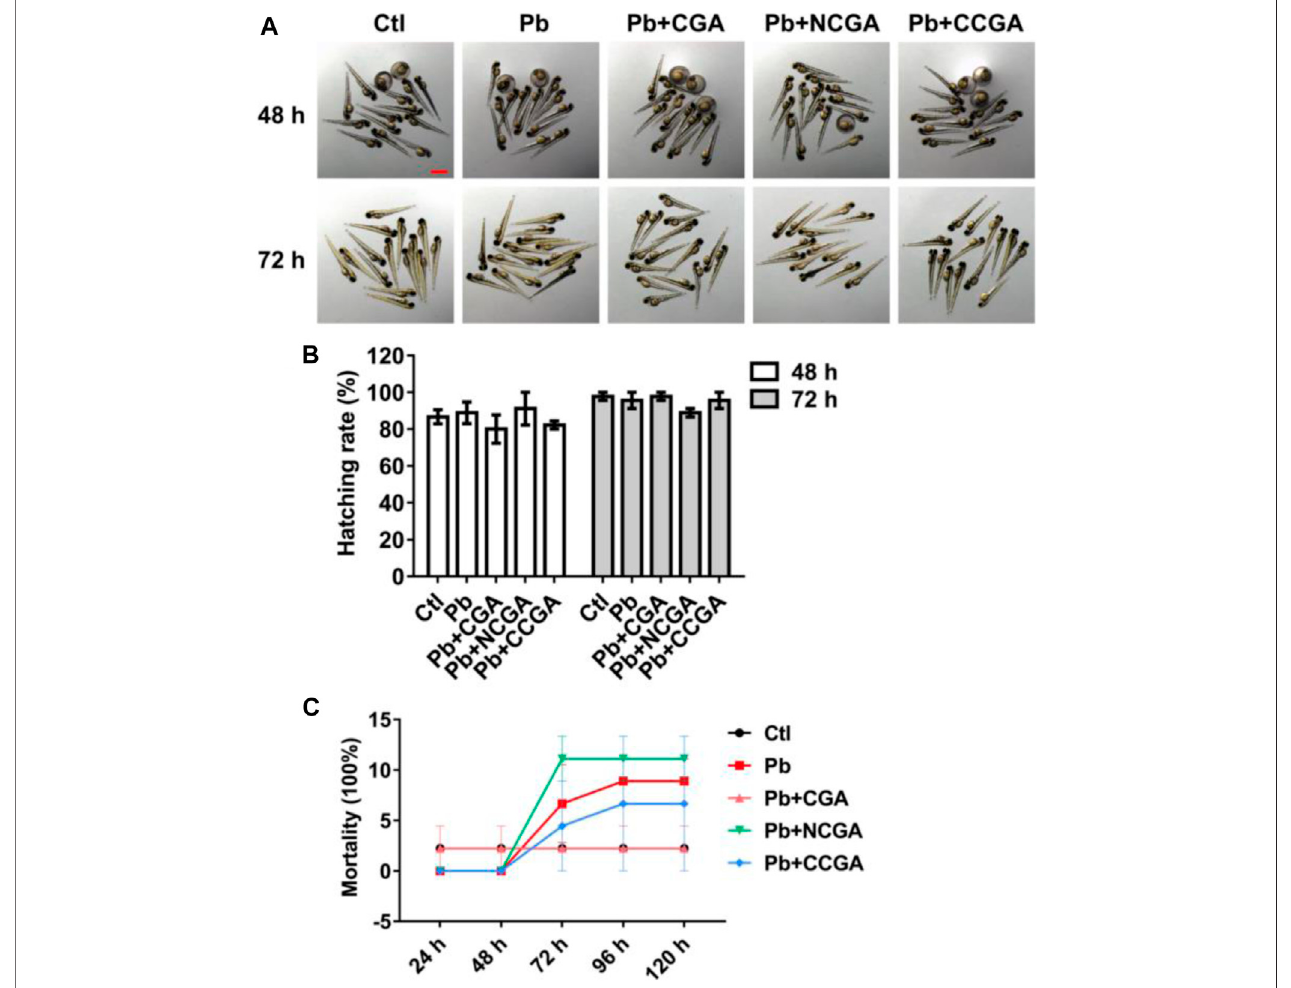
FIGURE1| Hatching and mortalityrateofzebra fi shlarvae. (A) Representativeimagesofthemorphologyofzebra fi shexposed todifferentgroupsat 48and 72 hpf (scale bar, 1 mm). (B) Hatching rates at 48 and 72 hpf. (C) Mortality rate of zebra fi sh in different groups from 24 to 120 hpf.